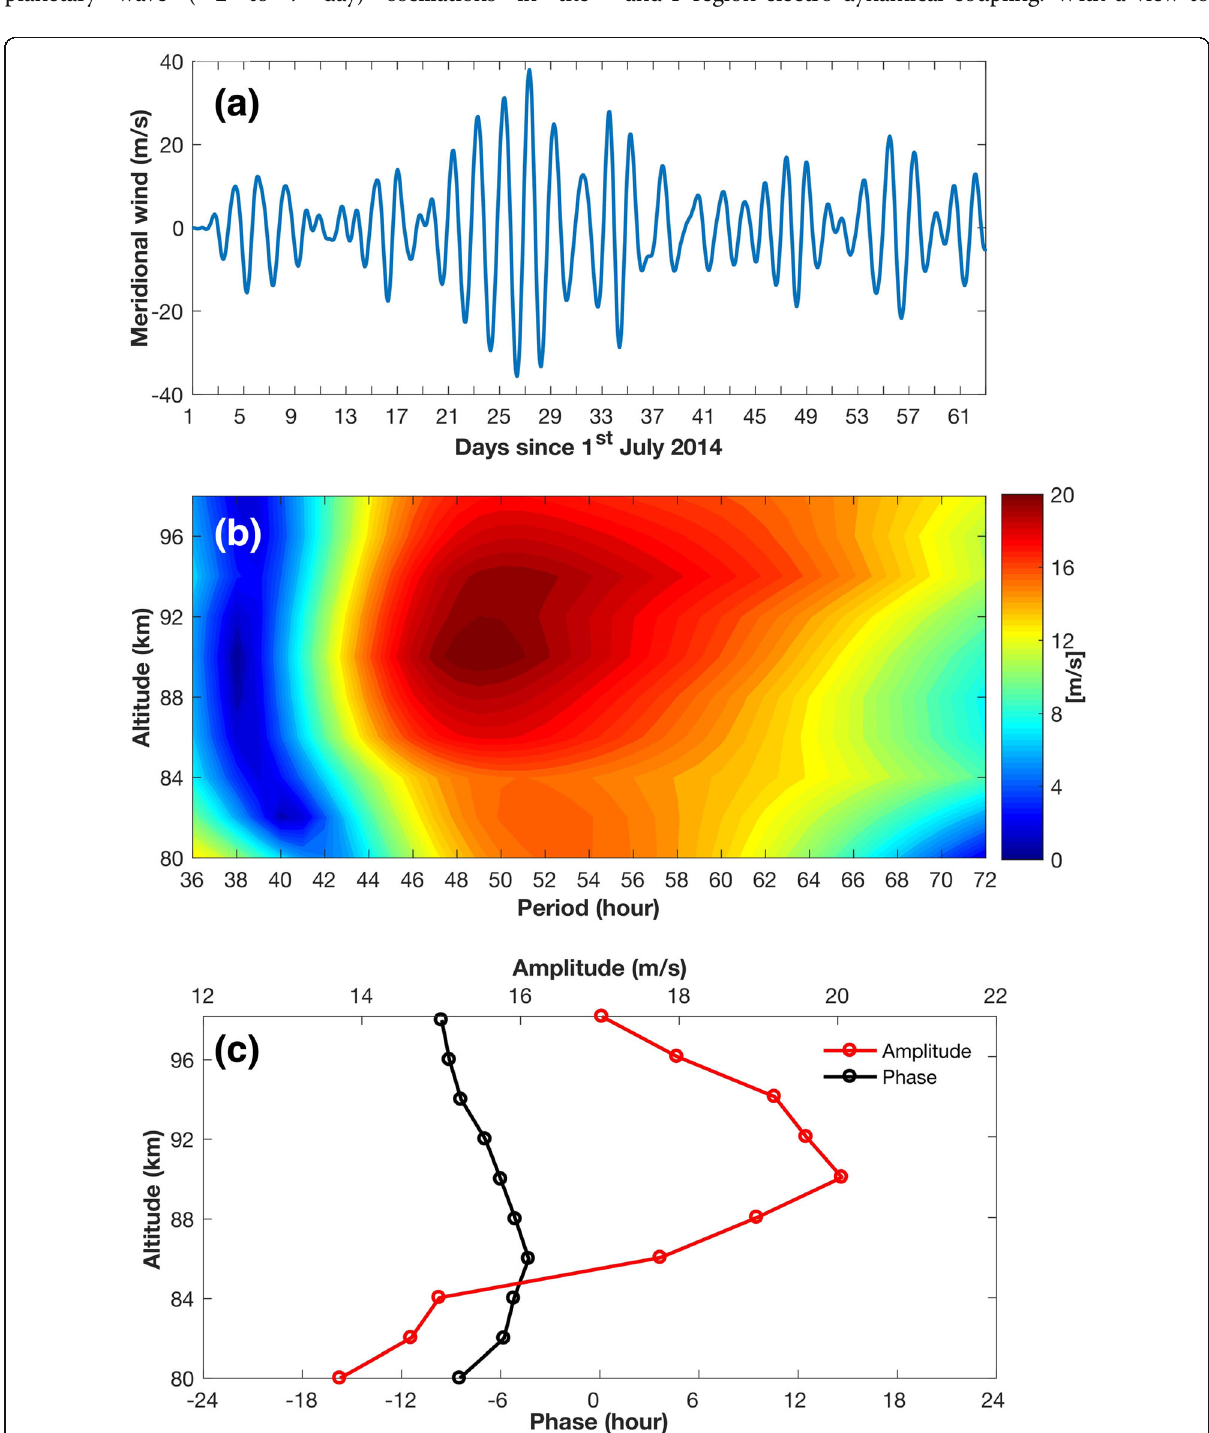
Fig. 10 a The 2-day planetary wave packet (1.5 – 2.5-day bandpass filtered) in the meridional wind from Indian low-latitude station, Kolhapur, during 01 July 2014 – 31 August 2014. b Amplitude spectra of meridional wind at 80 – 98 km altitudes showing the quasi-2-day wave periodicity of ~48 – 52 h. c Altitudinal variation of amplitude (red) and phase (black) of quasi-2-day wave taken at 48 h